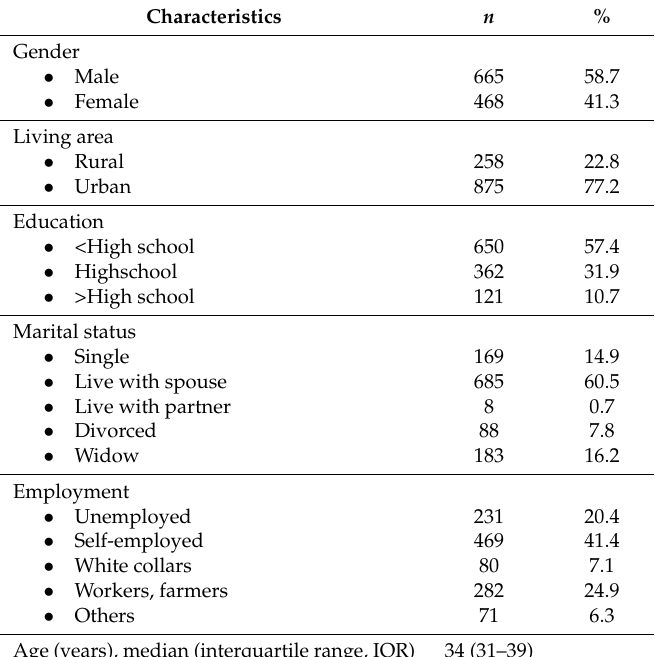
Table 1. Demographic characteristics of participants ( n =